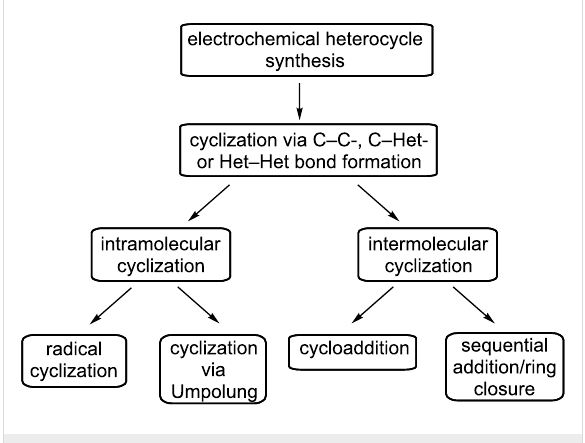
Figure 1: Common types of electrochemically induced cyclization